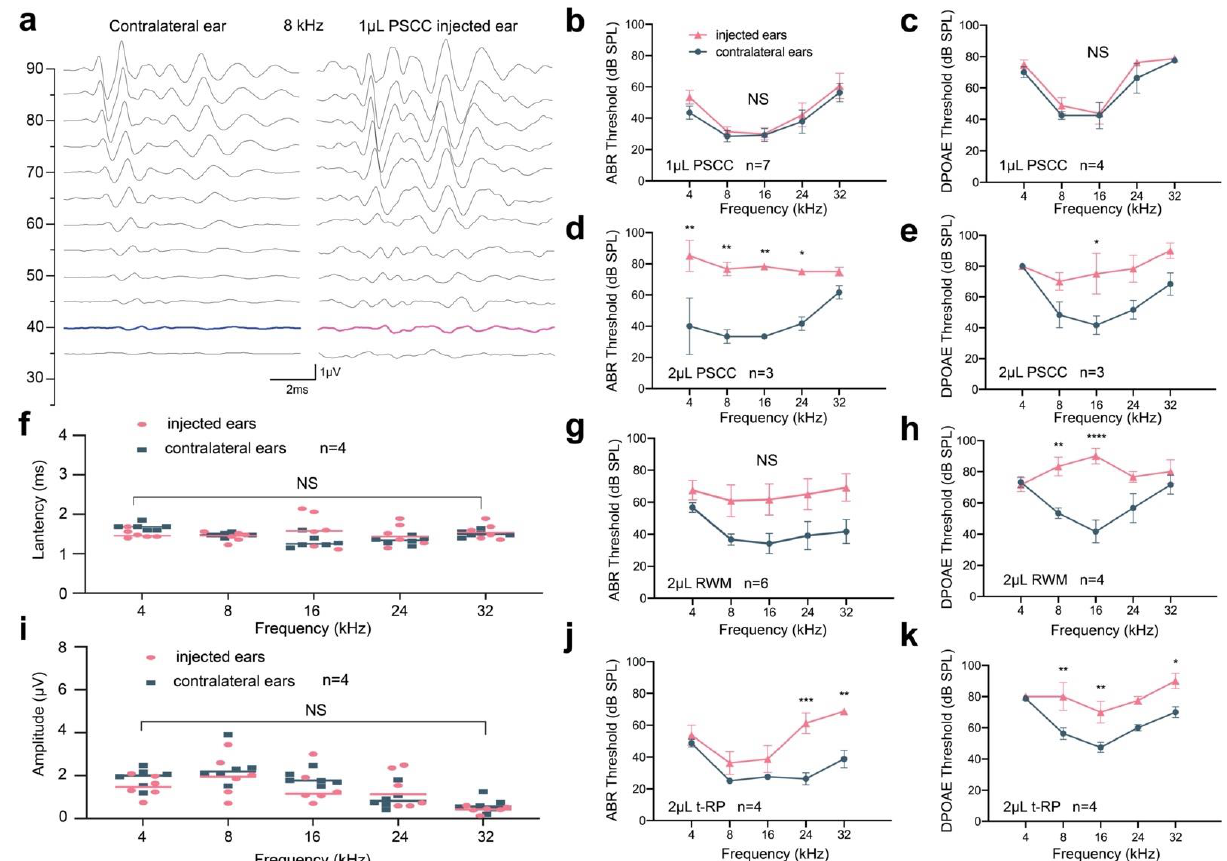
Figure 3. Cochlear injection of 1 µ L AAV-Anc80L65 via PSCC canalostomy in adult mice (4–6 weeks old) does not impair hearing function. ABRs and DPOAEs were recorded at 2 weeks after the injection. ( a ) ABR waveforms from the representative contralateral ear and the ear injected with 1 µ L AAV-Anc80L65 vector through the PSCC approach at 8 kHz. The blue trace indicates the threshold of the contralateral ear while the pink trace indicates the threshold of the injected ear. The scale bar applies to all traces. ( f , i ) Latencies ( f ) and peak amplitudes ( i ) of ABR wave 1 evoked by 90 dB SPL at 4, 8, 16, 24, and 32 kHz in the AAV-Anc80L65-injected ears compared with the contralateral ears 2 weeks after 1 μL PSCC injection. ( b – e , g , h , j , k ) ABR and DPOAE tests showed no threshold shifts in the 1 μL PSCC group inner ears compared with the contralateral non -injected control ears, whereas the hearing threshold increased at different frequencies to different degrees in the remain- ing groups. Two-way ANOVA with Bonferroni correction was performed for multiple comparisons for ABR and DPOAE tests. * p < 0.05; ** p < 0.01; *** p < 0.001; **** p < 0.0001 . To further evaluate the difference in hearing function in each group, we analyzed all of the hearing results together (supplementary Figure S4). We found statistically signifi- cant differences in ABR measurements between the 1 μL PSCC group and 2 μL PSCC gr oup at 4, 8, and 16 kHz and between the 1 μL PSCC group and RWM group at 8 and 16 kHz. Statistically significant differences in DPOAEs were also recorded between the 1 μL PSCC group and 2 μL PSCC group at 8 and 16 kHz, between the 1 μL PSCC group and RWM g roup at 16 kHz, and between the 1 μL PSCC group and t -RP group at 8 and 16